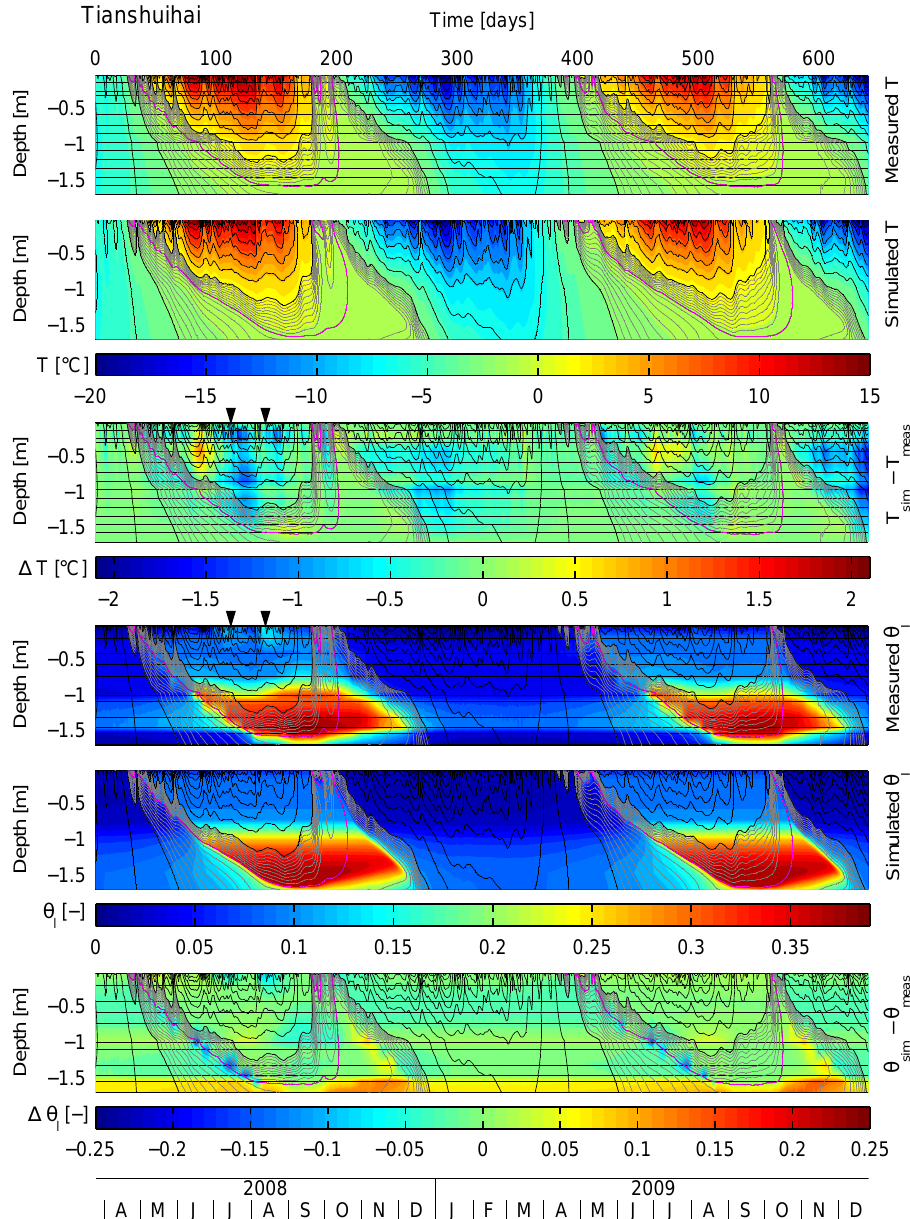
Fig. 6. Measured data and simulation results for the conduction scenario (iii) of the Tianshuihai simulation. Graphical representation identical to that of Fig. 5. Arrows mark the rain events discussed in Sect. 6.3.